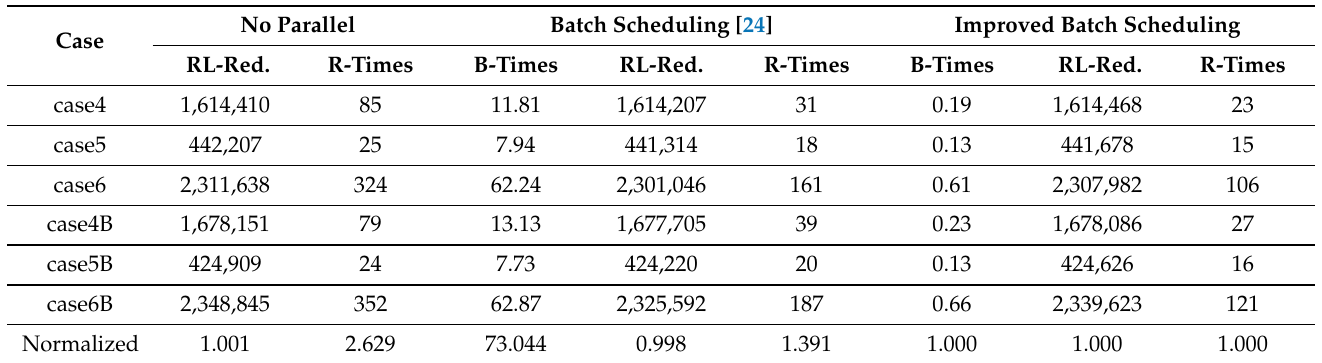
Table 2. Comparison results with the batch scheduling